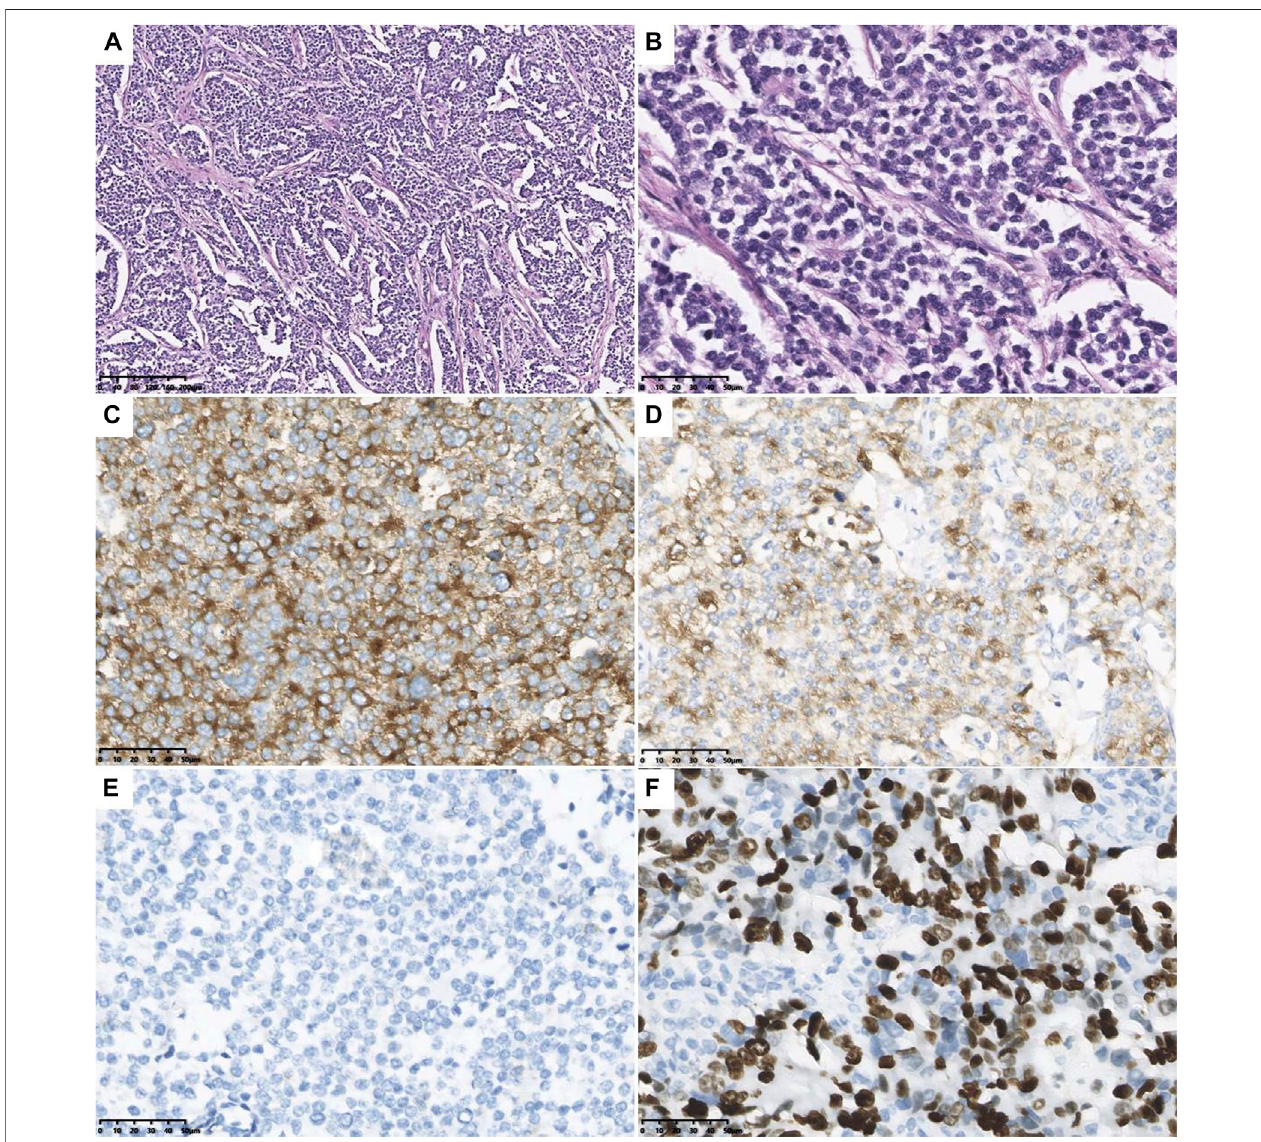
FIGURE 3 | Microscopical and immunohistochemical images of tumor cells. Microscopy revealed the tumor composed of small round blue cells forming rosettes withscant cytoplasm, fi brillary matrix material, and hyperchromaticnuclei (A) :H&Estaining,originalmagni fi cation×10; (B) H&Estaining,originalmagni fi cation ×40). The tumor cells are positive for CD57 (C) and Syn (D) , and negative for CgA (E) . The Ki-67 proliferation index was about 25 – 30% (F) .